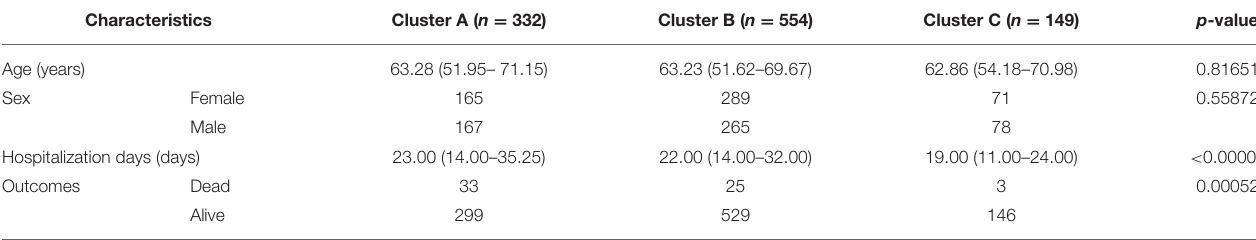
TABLE 4 | Demographic characteristics of three COVID-19 clusters identified by Factor Analysis of Mixed Data-based cluster